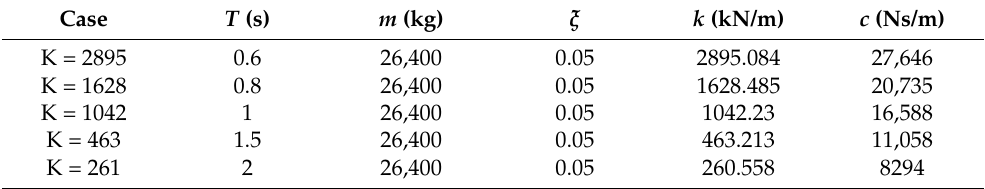
Table 6. The parameters of the mass–spring–damper